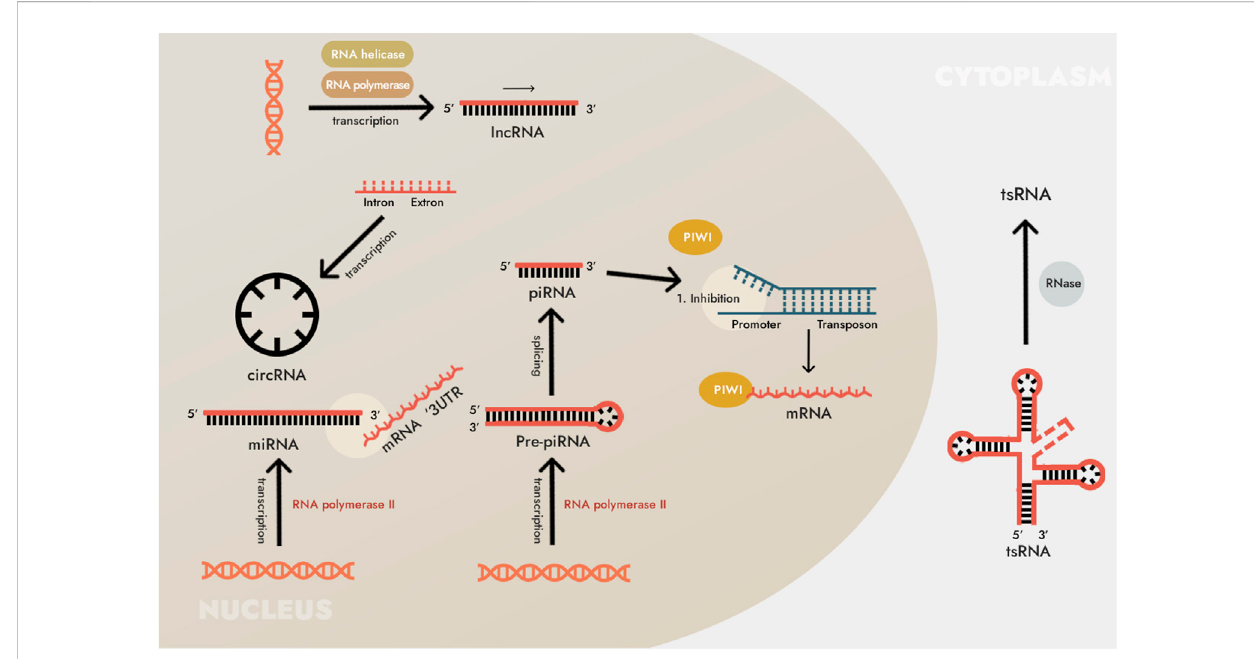
FIGURE 1 Biosynthesis of non-coding RNAs (ncRNAs). The main types of ncRNAs are microRNAs (miRNAs), long non-coding RNAs (lncRNAs) and circular RNAs (circRNAs). In addition to those listed, many other types of RNA are also included in ncRNAs. For instance, small ncRNAs include RNAs that interact withPIWIproteins(piRNA,piwi-interactingRNA,piwiRNA),transferRNA(tRNA)-derivedsmallnon-codingRNA(tsRNA),andothers.However,thesetypes of ncRNAs have not been found in human cells, and/or their pathogenetic and diagnostic (as well as therapeutic) signi fi cance has not yet been shown, so we do not consider them